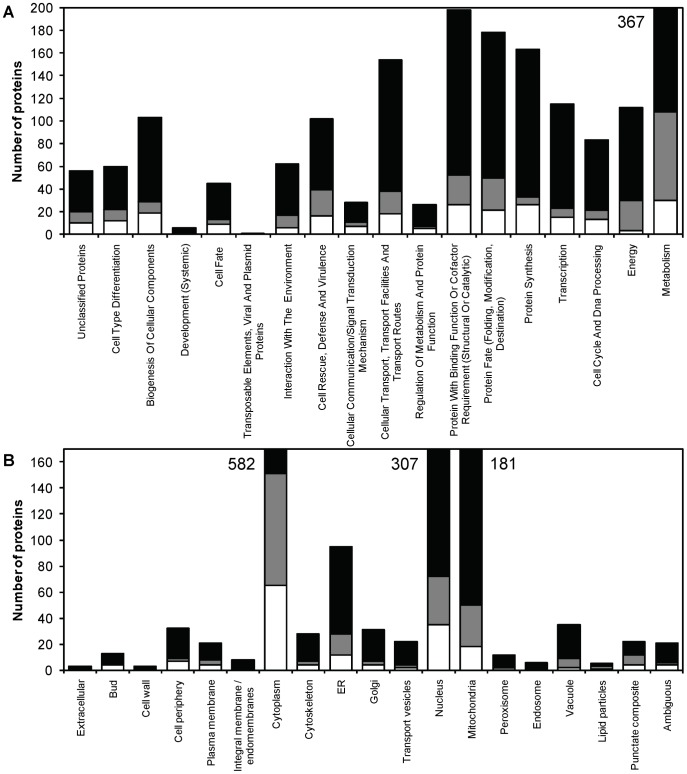
Functional classification and cellular localization of proteins identified by the nLC-MS/MS approach.Distribution of functional categories (A) and cellular localizations (B) of identified proteins in encapsulated and free S. cerevisiae, showing the number of proteins in the respective fold change class (non-regulated – black, up-regulated – grey, down-regulated – white) per functional category and cellular localization, respectively. Numbers next to bars indicate the total number of proteins in the category when extending past the y-axis range.